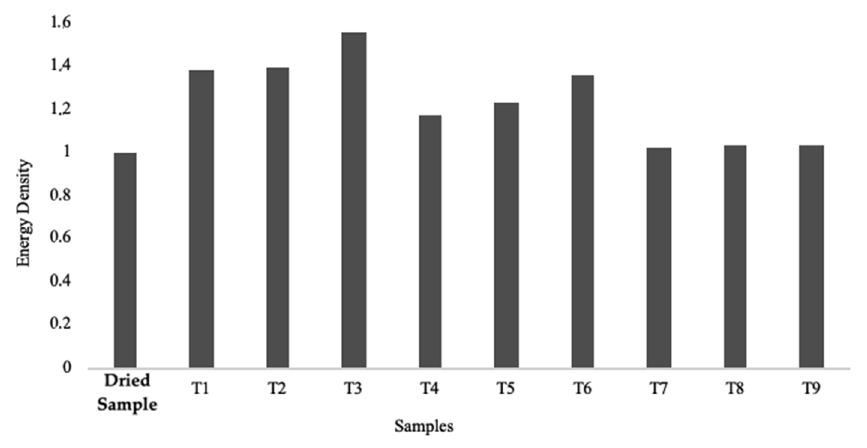
Figure 10. Graphic representation of the energy density obtained for dry and all torrefied samples. Dry biomass was used as the control sample.